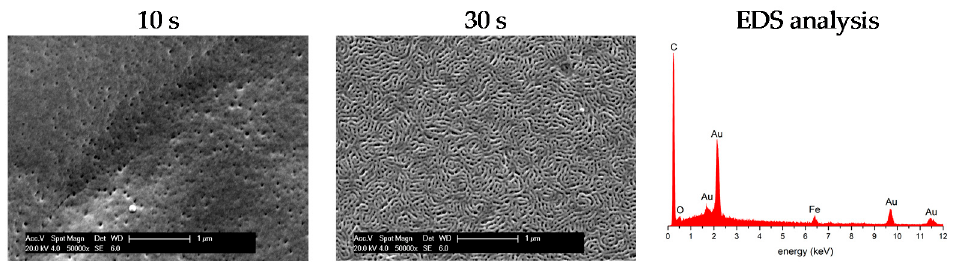
Figure 5. SEM images and EDS anaylsis of block copolymer membranes prepared of a 2:1 wt %